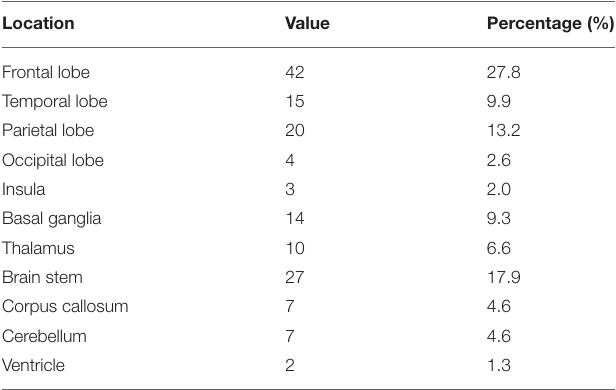
TABLE 2 | Localization of target lesion in 151 stereotactic biopsies.